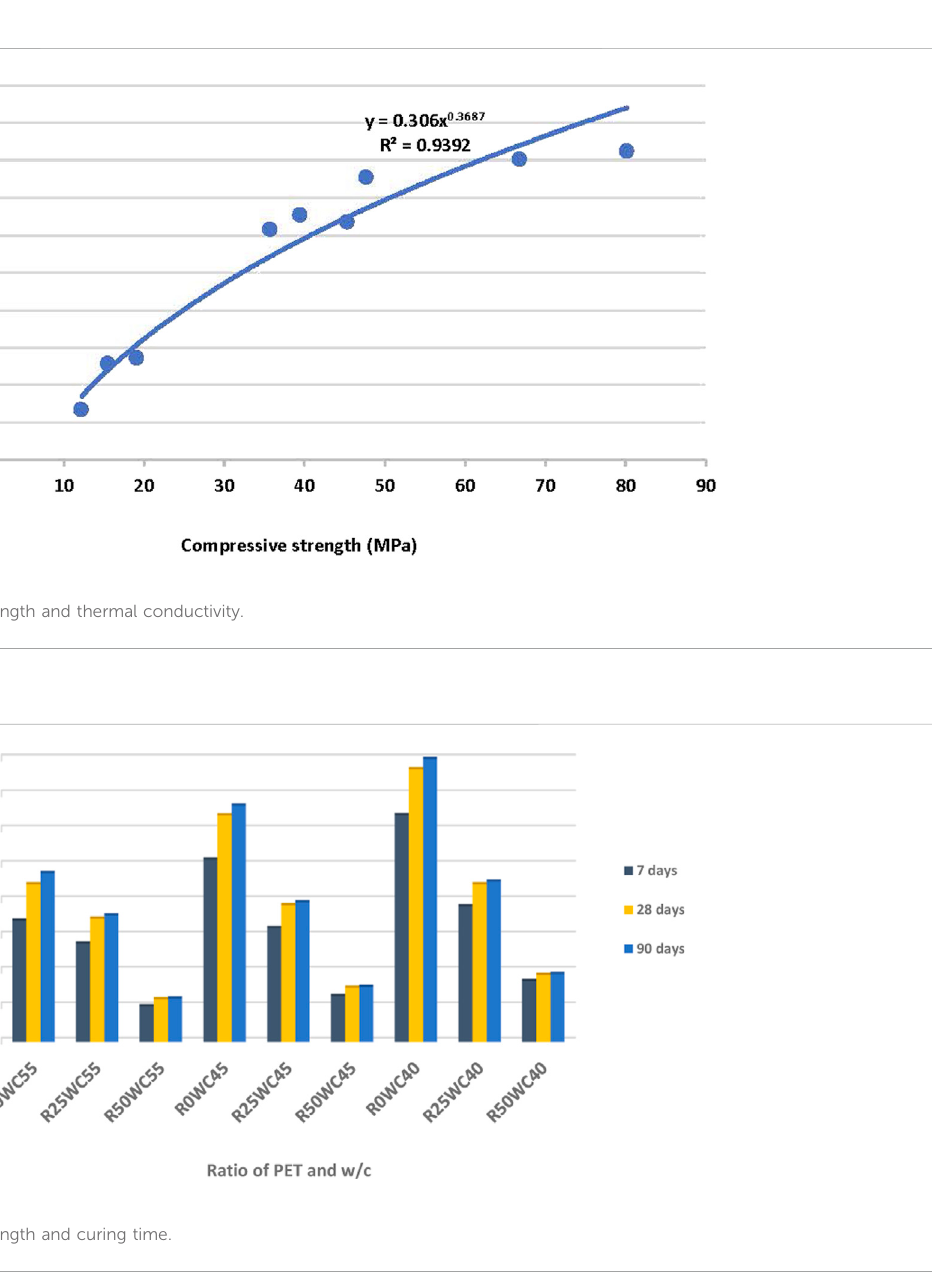
Relationship between compressive strength and curing